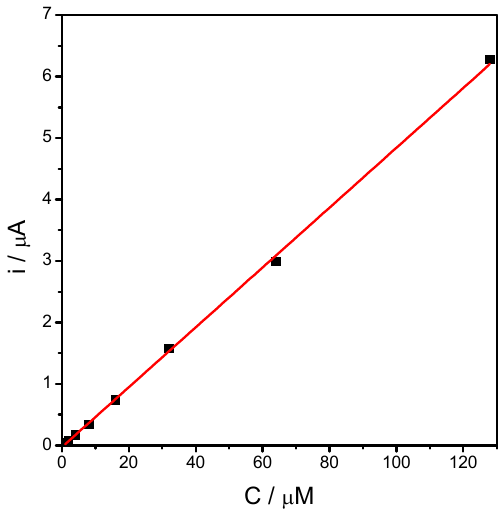
Figure 8. Calibration curve for amperometric response of MnO x ‐ LS modified electrode.